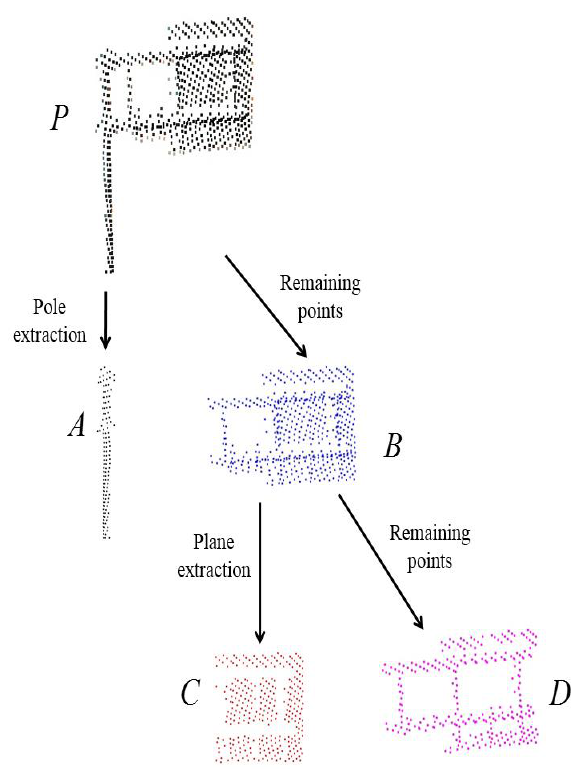
Figure 14. Five groups of point-sets